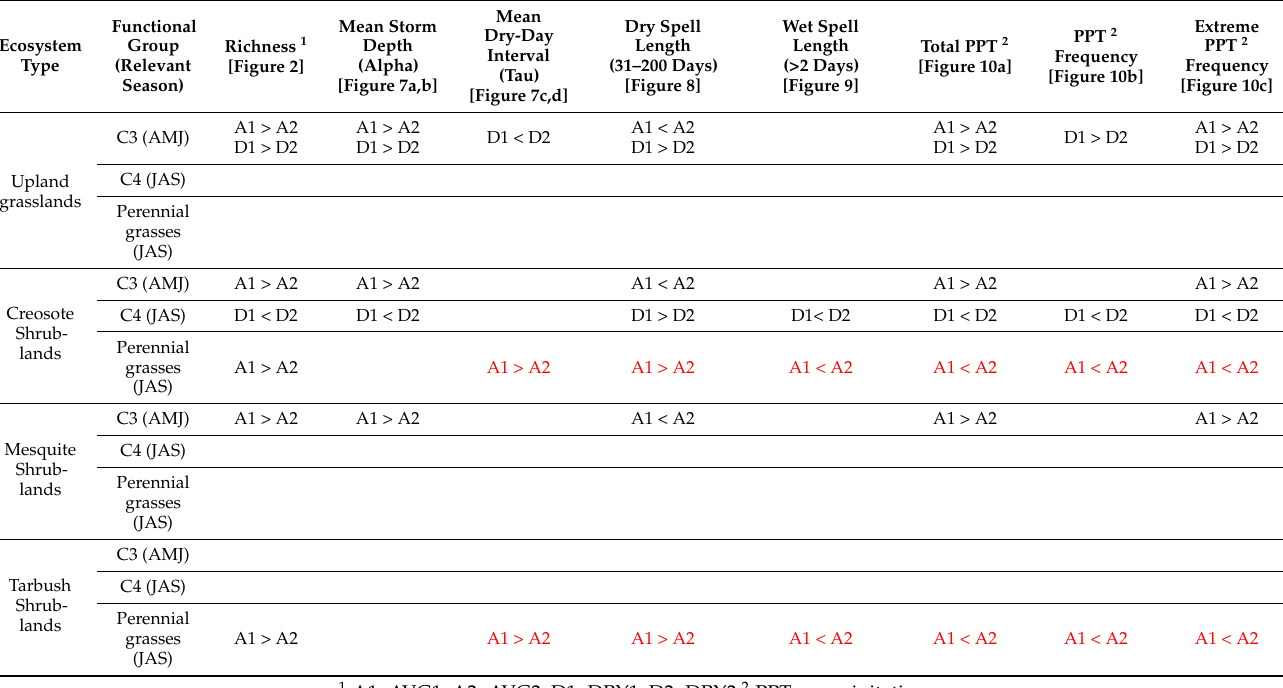
Table 1. Summary of significant differences in richness or precipitation characteristics between periods with similar total amounts of precipitation 1 . Counter-intuitive results are shown in red text. Figures are identified in column headers.